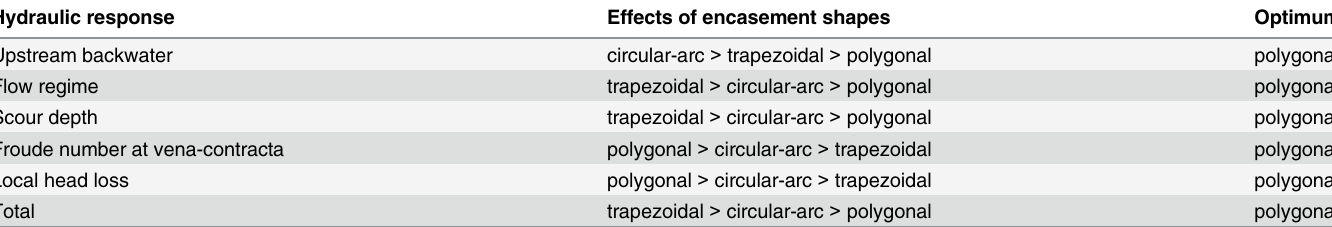
Table 7. Summary of sensitivity of hydraulic response to different